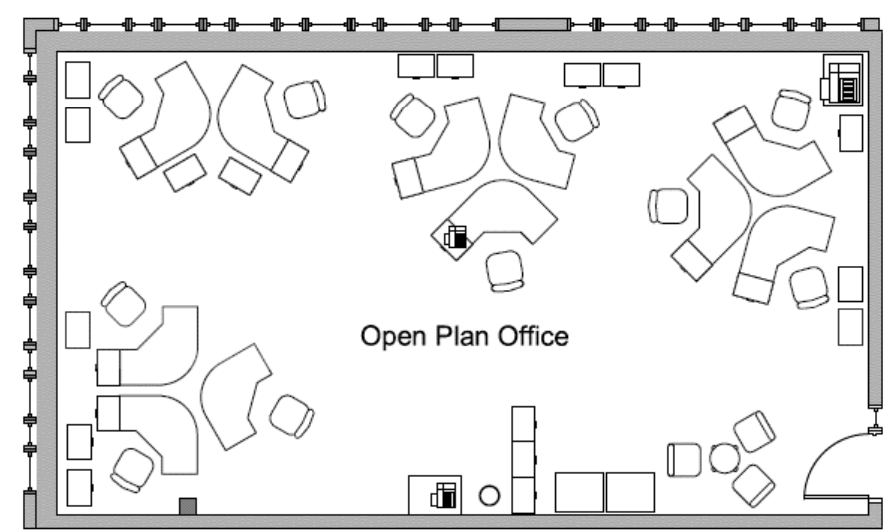
Figure 2. Layout of open plan office in NBERT.